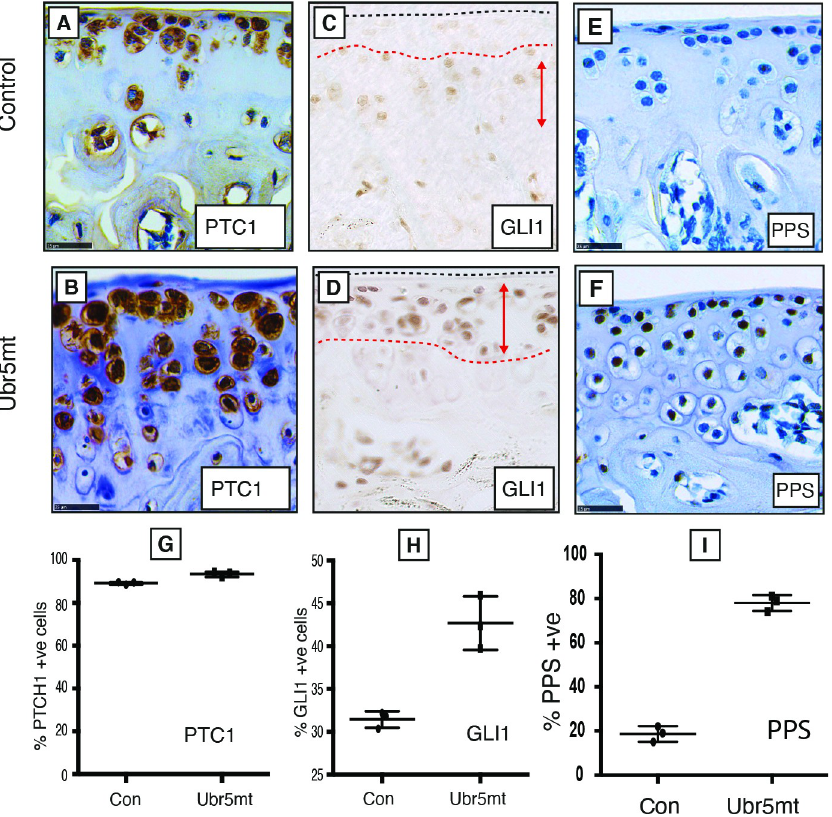
Fig 8. Impaired Ubr5 function results in increased canonical and decreased non-canonical HH signalling. Immunohistochemical analysis of six-week-old control and Ubr5 mt tibial AC examined for markers of canonical HH pathway activity. Relative to (A, C) control, (B, D) Ubr5 mt AC displayed increased staining intensities for PTCH1 (A, B) and GLI1 (C, D) with GLI1 exhibiting expanded expression domains (D, double-headed arrows). (E, F) Staining for PKA phosphorylated substrates (PPS) revealed (Q) Ubr5 mt AC exhibited increased numbers of robust staining cells. The number of expressing cells is quantified in (G-I). Quantification confirmed Ubr5 mt AC to harbour increased numbers of positive cells for all antigens except PTCH1. Graphs represent the percentage of positive cells, regardless of staining intensity, with the mean and s.e.m indicated. n = 3 biological replicates. Chi-square test on pooled cells count data. p = < 0.0008, except PTCH1 which was not